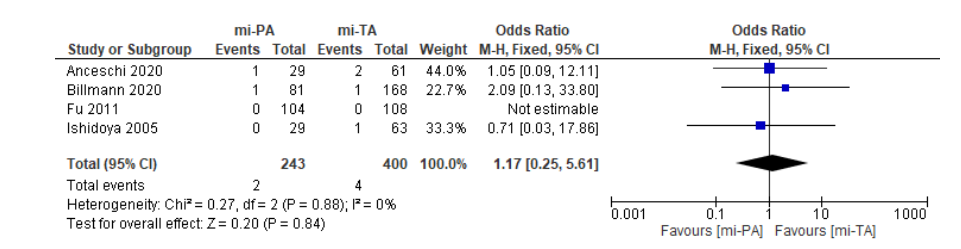
( a ) Forest plot representing analysis of mean operative time.